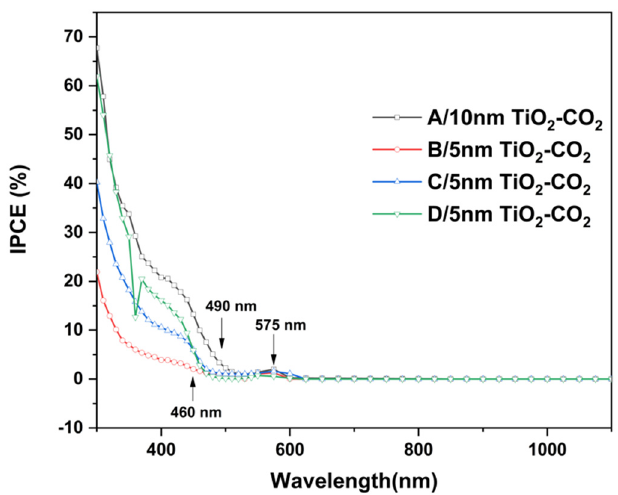
Figure 7. IPCE curves of PEC CO 2 reduction measured at − 0.2 V RHE on samples A–D with TiO 2 coat ‐ ing on p ‐ GaP surface in 0.5 M NaCl and 10 mM pyridine solution saturated with CO 2 . TiO 2 ‐ coated p ‐ GaP photocathodes grown on Si were characterized with respect to PEC CO 2 reduction under the same conditions, as shown in Figure 8. For samples E